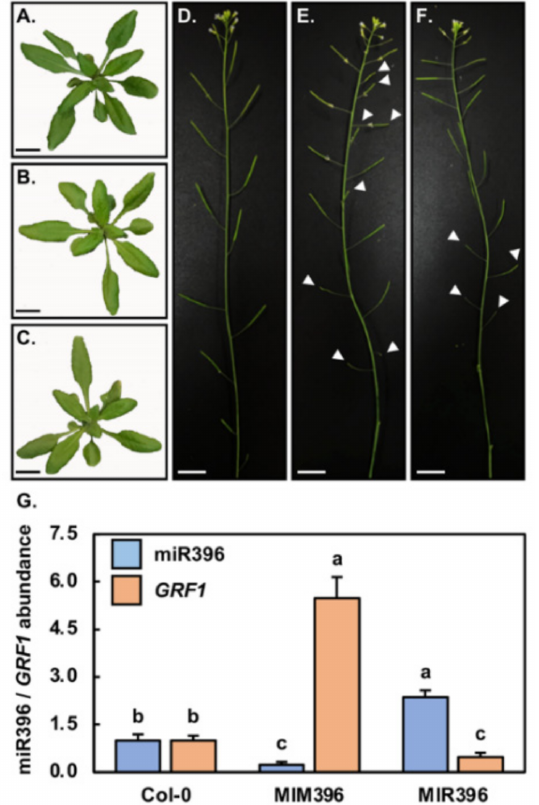
Figure 1. Phenotypic and molecular assessment of MIM396 and MIR396 transformant lines. Vegeta- tive phenotypes displayed by 25-day-old soil grown Col-0 ( A ), MIM396 ( B ), and MIR396 ( C ) plants. Scale bar = 1.0 cm. Comparison of the reproductive development of 40-day-old soil-grown Col-0 ( D ), MIM396 ( E ), and MIR396 ( F ) plants. Scale bar = 2.0 cm. ( G ) RT-qPCR assessment of the abundance of miR396 and the expression of one of the primary target genes of miR396-directed expression regulation in Arabidopsis , GRF1 , in the rosette leaves of 25-day-old soil grown Col-0, MIM396 , and MIR396 plants. Error bars represent the standard deviation of four biological replicates. Statisti- cal data were analyzed using one-way ANOVA and Tukey’s post hoc tests. Statistically significant differences indicated by a different letter ( p < 0.05) above a histogram